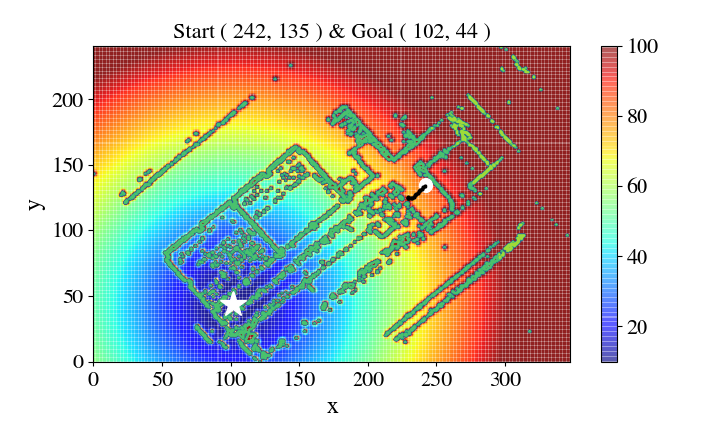
Figure 17. Failed scenario at (242, 135), before the map is